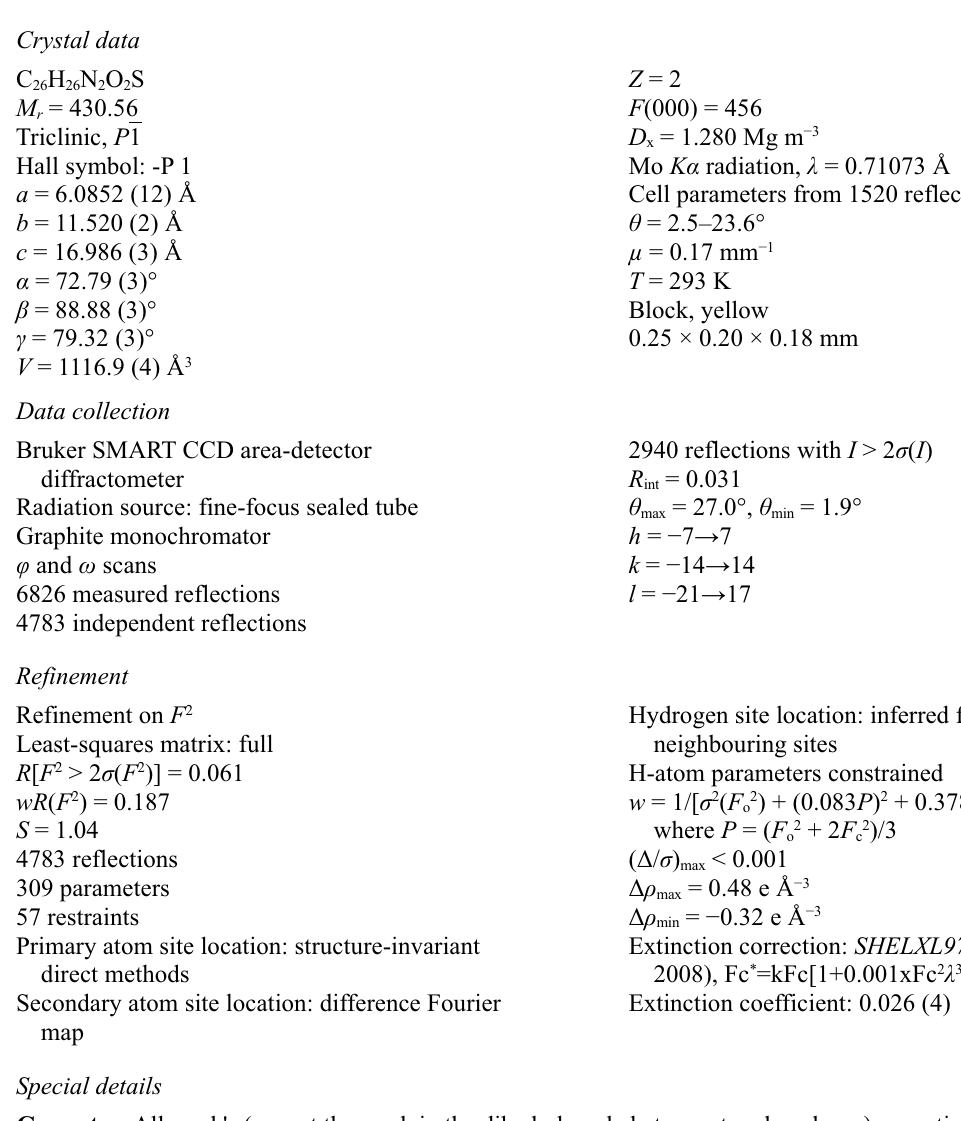
Figure 1 The structure of the title compound showing 30% probability displacement ellipsoids and the atom-numbering scheme.